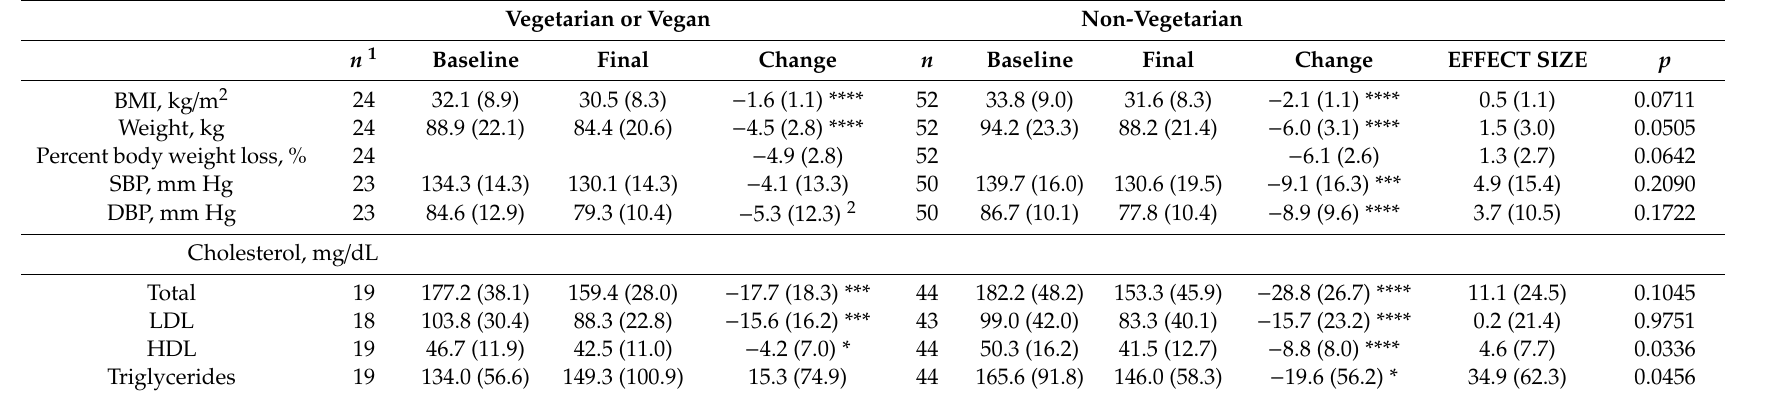
Table 4. Outcomes by vegetarian or vegan versus non-vegetarian status at baseline. Data are means ±